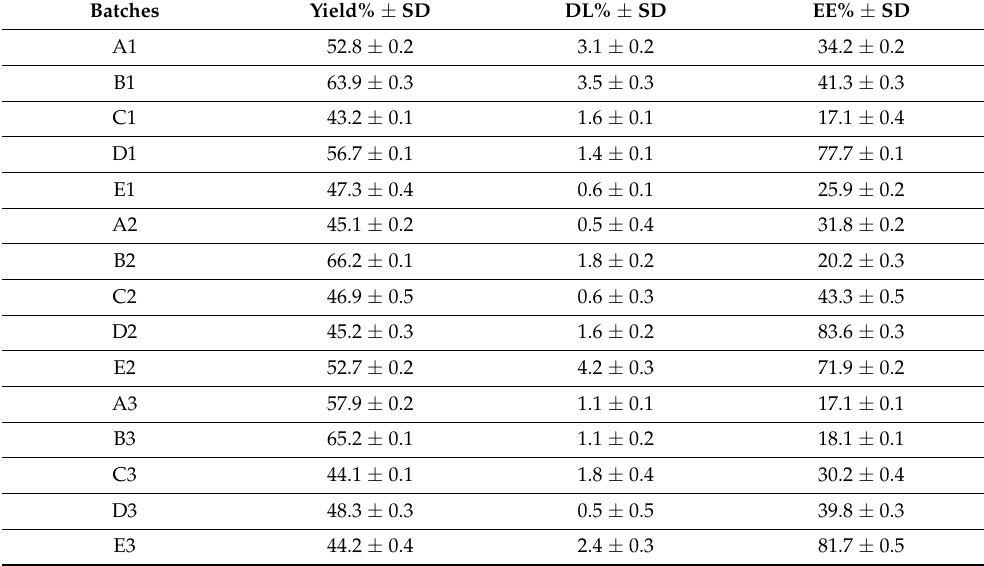
Table 1. Summary of yield, DL and EE ± SD (mean ± SD, n = 3) values for microparticle batches: A1 (retinyl palmitate and Eudraguard Biotic), A2 (retinyl palmitate and CAP), A3 (retinyl palmitate and WPs), B1 ( β -carotene and Eudraguard Biotic), B2 ( β -carotene and CAP), B3 ( β -carotene and WPs), C1 (retinyl acetate and Eudraguard Biotic), C2 (retinyl acetate and CAP), C3 (retinyl acetate and WPs), D1 (cholecalciferol and Eudraguard Biotic), D2 (cholecalciferol and CAP), D3 (cholecalciferol and WPs), E1 ( α -tocopherol and Eudraguard Biotic), E2 ( α -tocopherol and CAP), E3 ( α -tocopherol and WPs). The data are statistically different, with the exception of A1 compared to E2, A2 compared to D2, C3 compared to E3, for the yield; E1 compared to C2, A3 compared to B3, A2 compared to D3 and B2 compared to C3, for the DL; C1 compared to A3, for the EE. Batches Yield% ± SD DL% ±